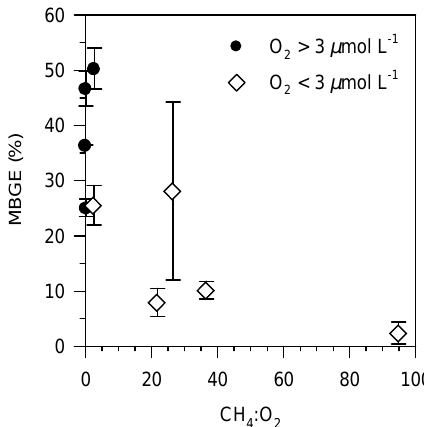
Figure 7. In Lake Kivu, relationship between the methanotrophic bacterial growth efficiency and the in situ CH 4 :O 2 molar ratio. Symbols represent mean MBGE values, vertical error bars represent standard deviation of replicates. The CH 4 :O 2 ratio was calculated with an O 2 concentration value of 3µmolL − 1 when observed in situ values were below the detection limit of the sensor (3µmolL − 1 )